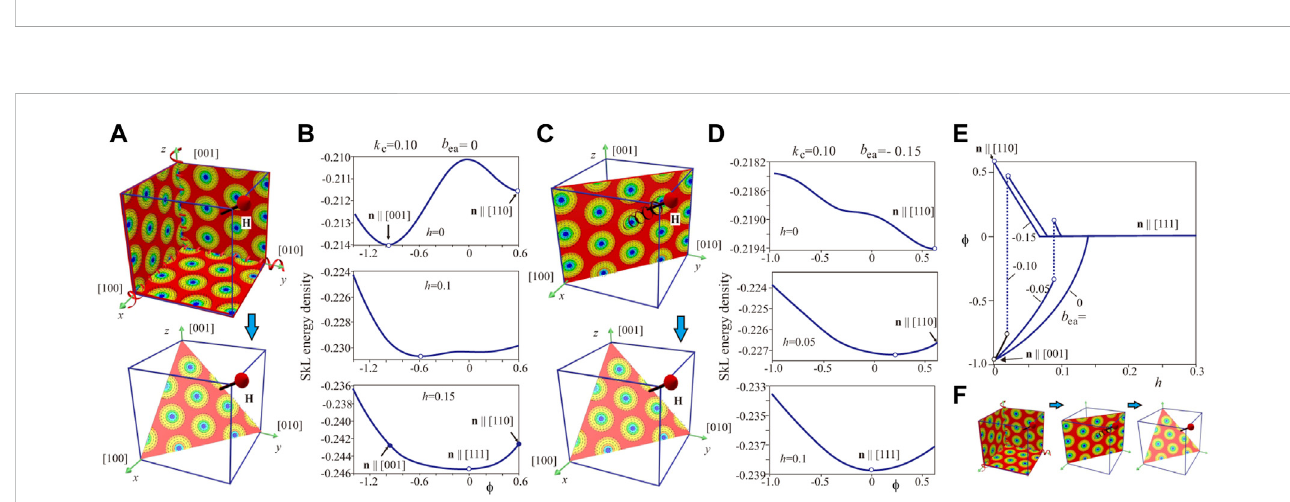
FIGURE 7 (color online) (A) Schematics of hexagonal skyrmion lattices occupying the {001} planes for the anisotropy set k c = 0.1, b ea = 0 at zero fi eld. The metastable SkLs select these planes because of the easy 〈 100 〉 axes of the cubic anisotropy. In an applied magnetic fi eld h (cid:1) [111] the oblique SkLs orient perpendicular to the fi eld, i.e., occupy the plane (111) [second panel in (A)].Such areorientation process is characterized by theenergydensity in (B) plottedin dependence on angle ϕ for different values of the fi eld. The local minimum corresponding to the SkL in the {110} plane [ fi rst and second panel in (B)] disappearswhen the SkLreaches theplane {111} [third panel in (B)]. The fi eld dependence of theangle ϕ corresponding to theglobal energy minimum in (B) is alsoshownin (E) dependingonthe fi eldandexhibitssmoothrotationinthiscase. (C) Schematicsofhexagonalskyrmionlatticesoccupyingthe{110}planesfor the anisotropy set k c = 0, b ea = − 0.15. The metastable SkLs select these planes because of the easy 〈 111 〉 axes of the exchange anisotropy. In an applied magnetic fi eld h (cid:1) [111] the oblique SkLs also rotate towards the plane (111) [second panel in (C)] as also indicated by the fi eld dependence ϕ ( h ) in (E) . The SkL energydensities in (D) exhibitonlyoneglobalminimum,whichmovestowardsthevalue ϕ =0withtheincreasing fi eld. Forthesetofcompetinganisotropies, the SkLs fi rst jump into a (110) plane and then undergo rotation into the plane (111) as indicated by the dependencies ϕ ( h ) in (E) and by the schematics in (F)